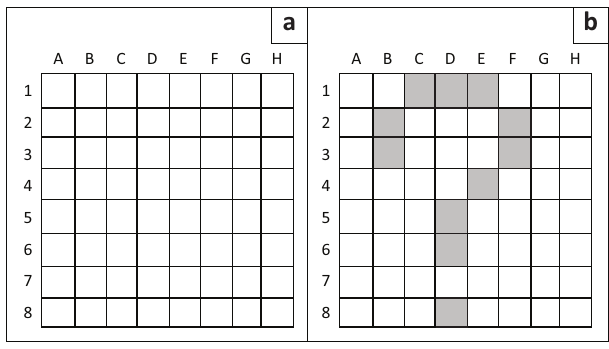
FIGURE 2: (a) An empty 8 × 8 grid. (b) Result obtained at the successful completion of Activity 1.